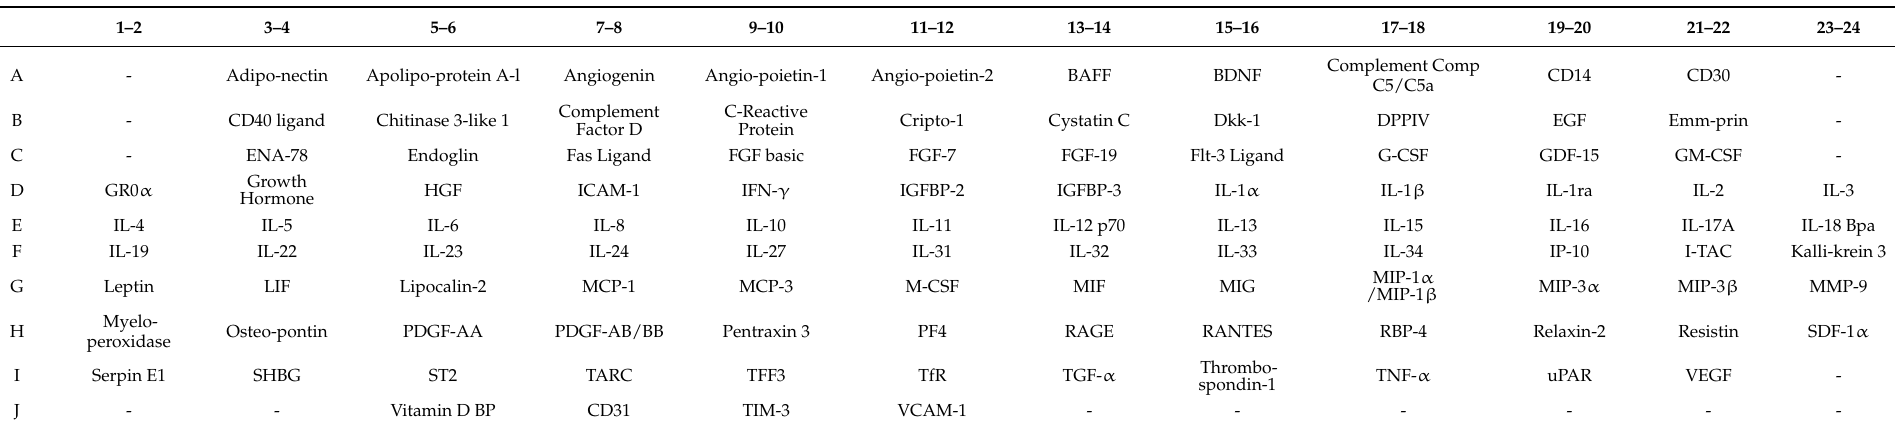
Table 1. Illustration of each cytokine position on the Proteome Profiling Array